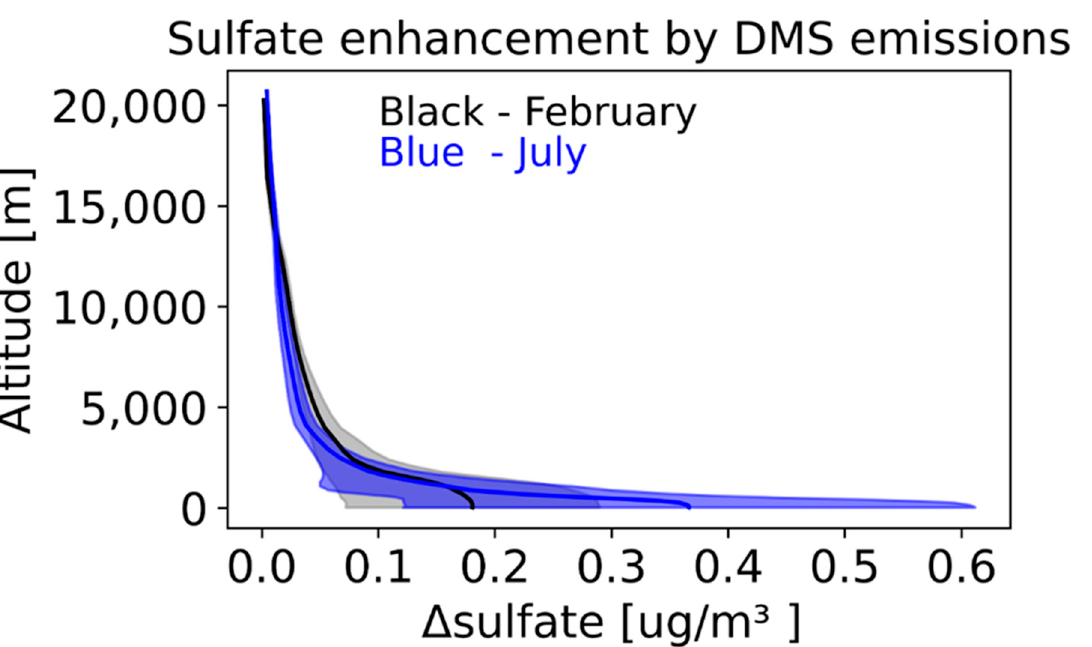
Figure 6. Impact of DMS emissions on sulfate aloft. Solid lines represent mean and shaded areas represent standard deviation of sulfate enhancement.